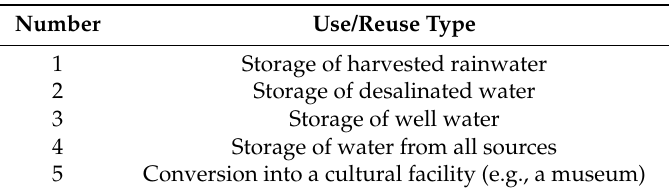
Table 2. Proposed Typology of Cistern Use.